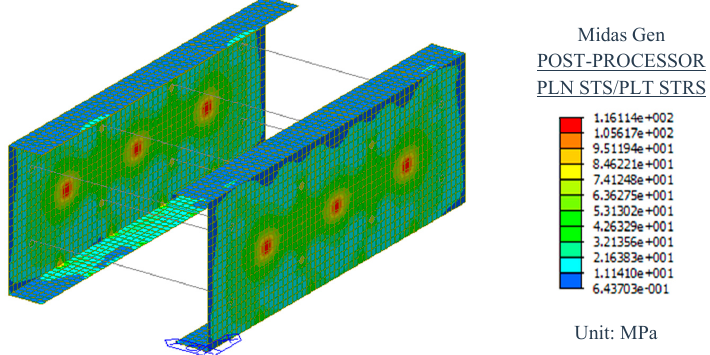
Figure 6. The numerical model and stress cloud diagram of the test device (unit: MPa).